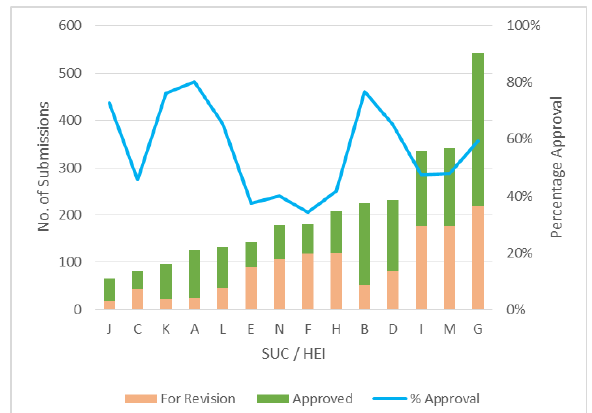
Figure 12. QA/QC Statistics based on Number of Submissions